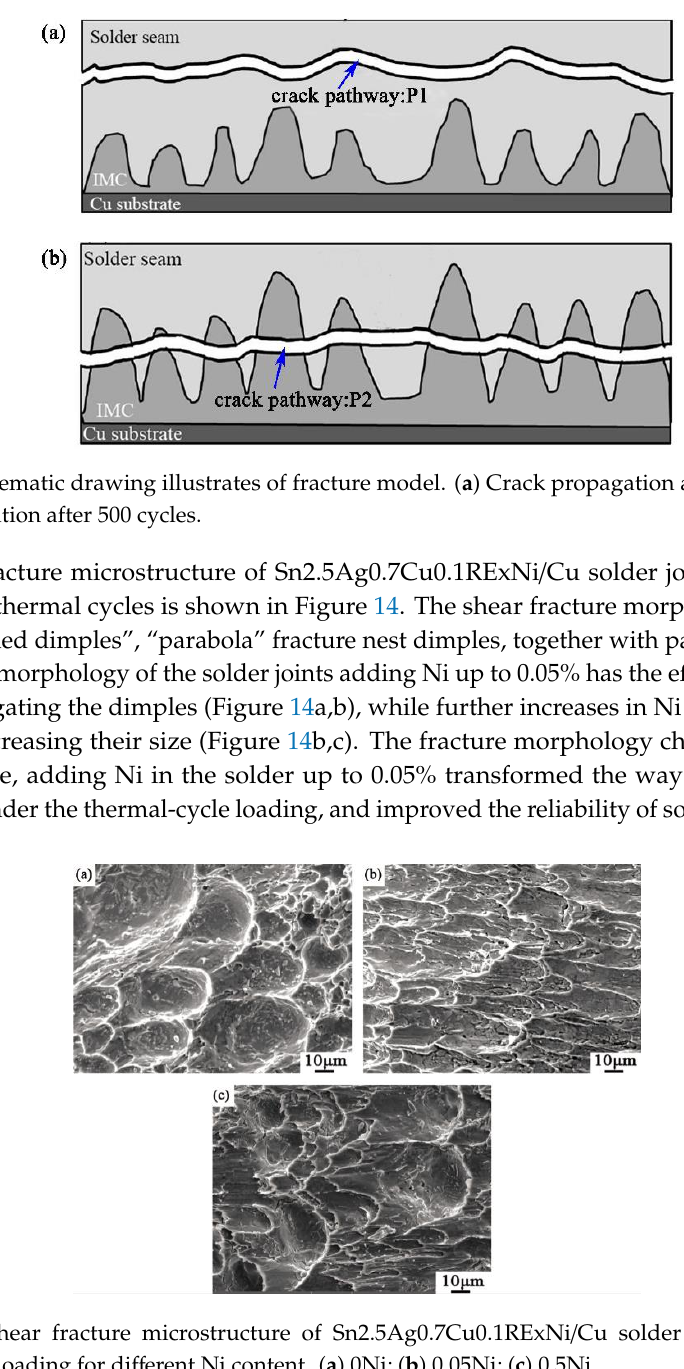
Figure 13. As the thermal cycle increased, the fracture pathway evolved from the ductile fracture of the solder seam (P1) to the ductile-brittle mixed-type fracture of solder seam / IMC layer (P2). Metals 2019 , 9 FOR PEER REVIEW